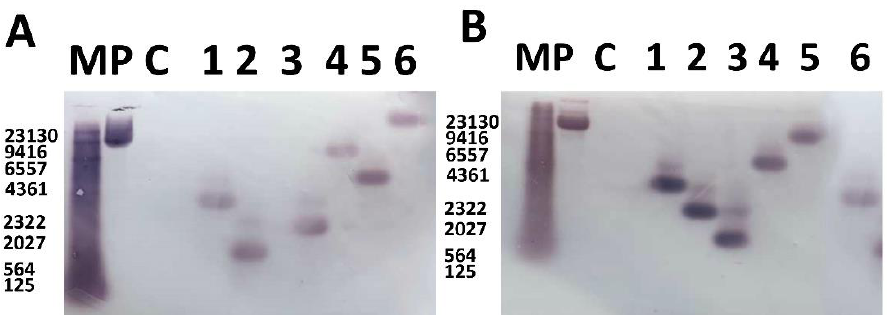
Figure 2. Verification of GmWRI14 expression in T0/T1 transgenic soybeans using Southern blot analysis. ( A ) Southern blot analysis of the copy number of the GmWRI14 expression cassette in T0 plants. ( B ) Copy number of the GmWRI14 expression cassette in T1 plants. P: positive control. C: control JN38. M: marker. The full-length original blot has been included in the additional files Figure